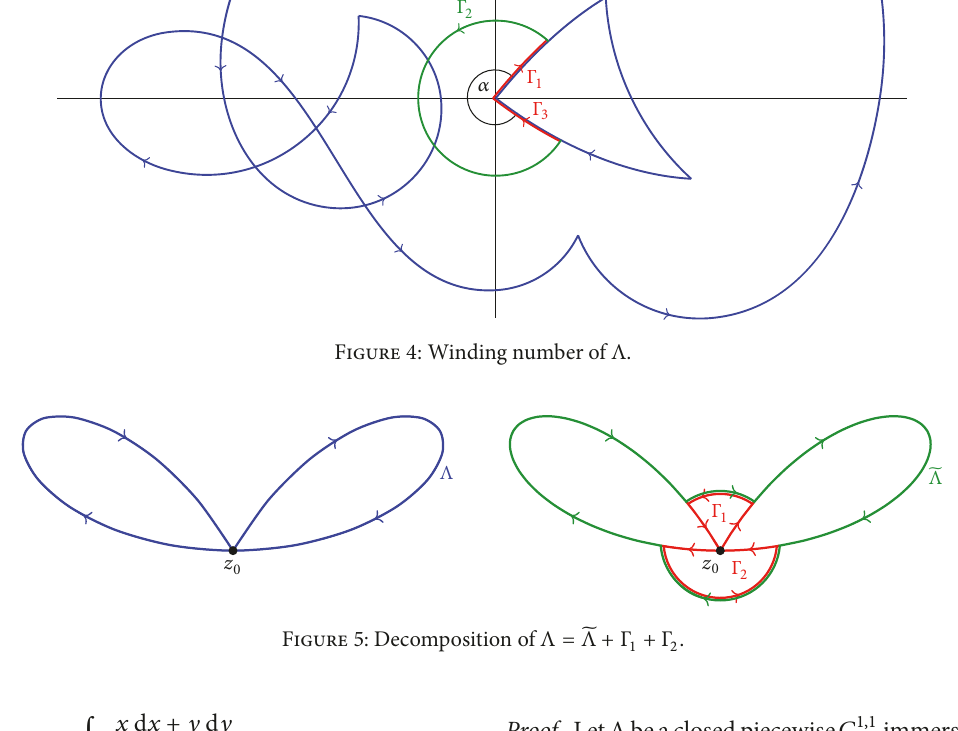
Figure 5: Decomposition of Λ =